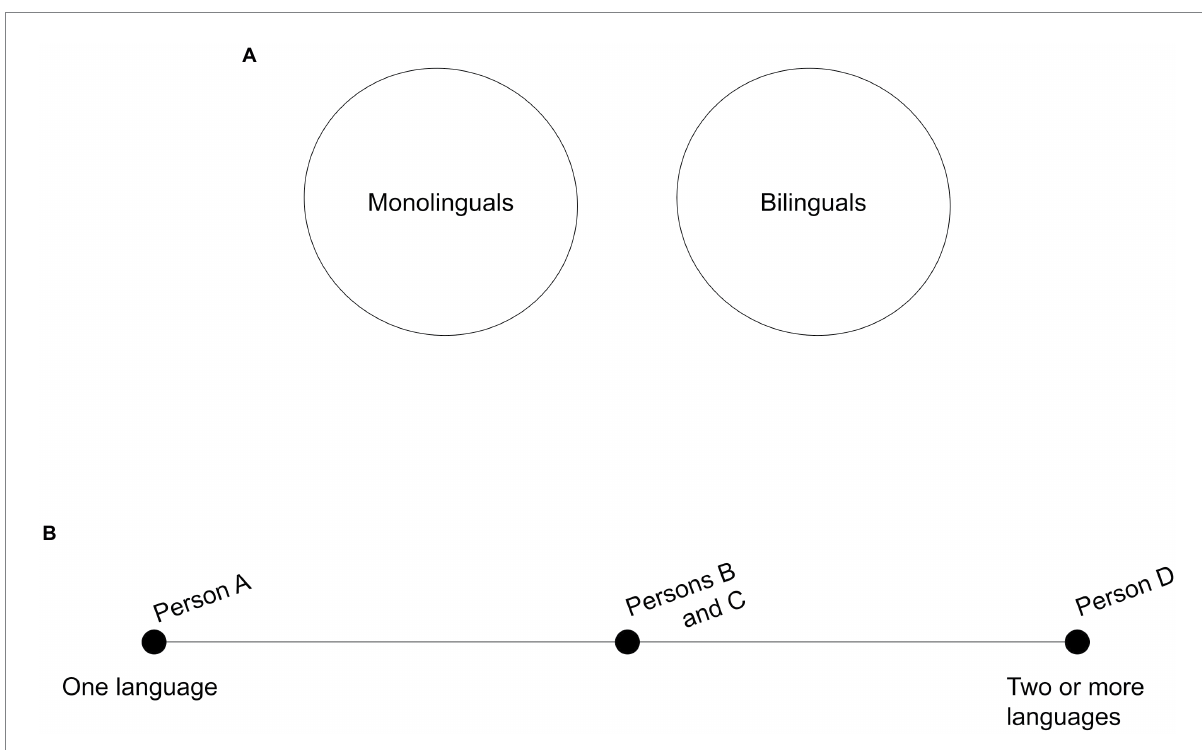
FIGURE 1 Conceived of as mutually exclusive categories, monolingualism and bilingualism divide all people into two groups based on whether they can speak one language or more than one (top, A ). But there are many people who seem to fall somewhere in the middle, suggesting that it is better to understand bilingualism and monolingualism as in continuity with each other rather than as discrete categories (bottom, B ): here, person A is monolingual, and person D is bilingual, but persons B and C have partial knowledge of more than one language and cannot be properly categorized at either extreme of the